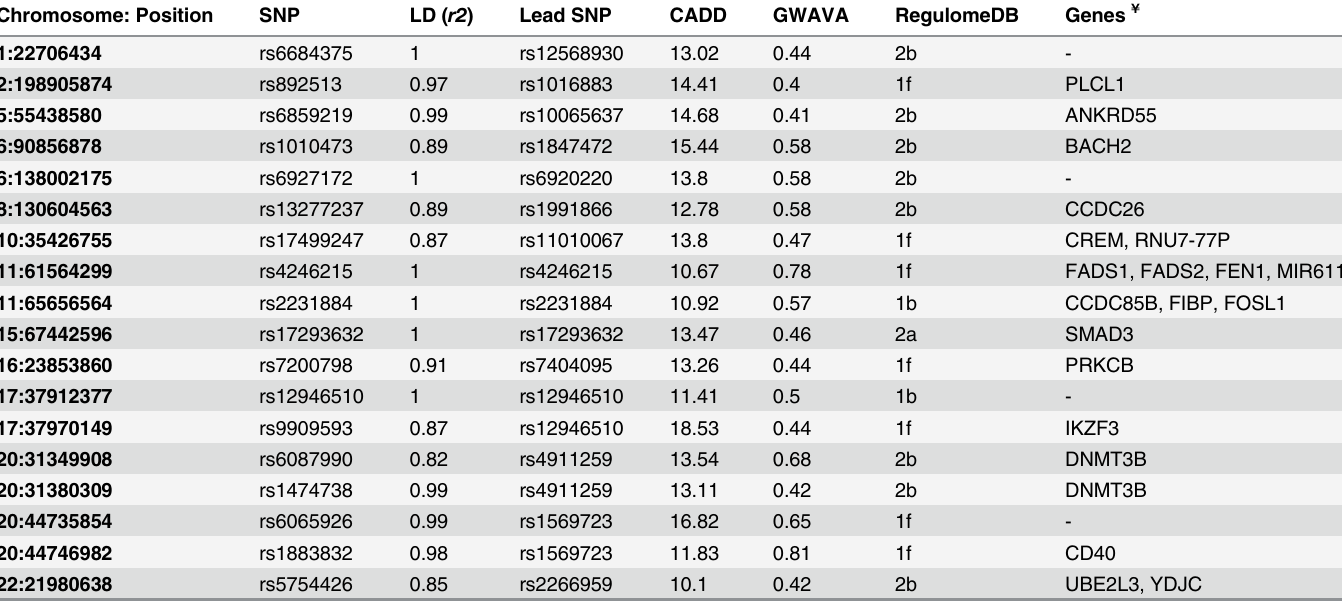
Table 2. List of prioritized putative regulatory SNPs. Chromosome: